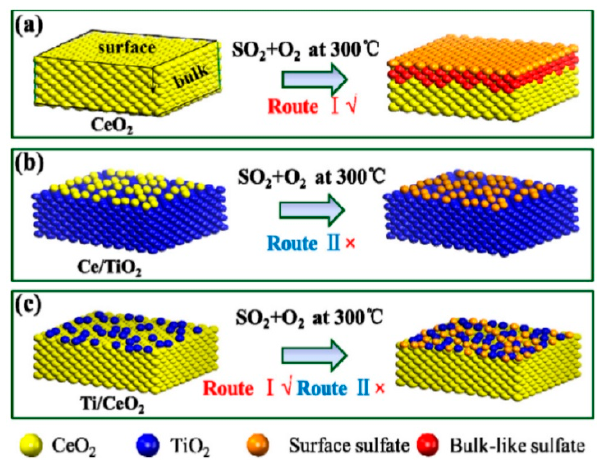
Figure 6. Proposed adsorption model of SO 2 : ( a ) CeO 2 , ( b ) Ce/Ti and ( c ) Ti/Ce [40].